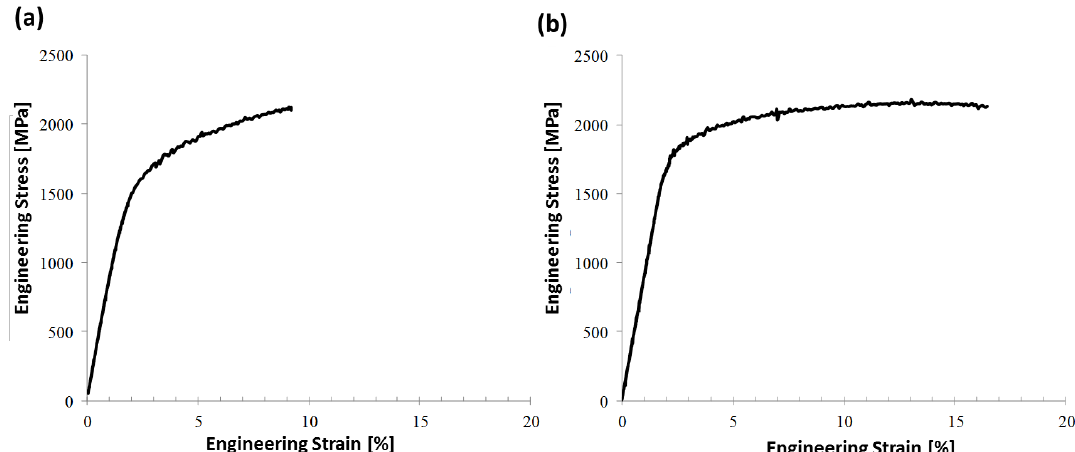
Figure 2. Engineering tensile strain-stress curves of two nanostructured bainite samples from different steels, both containing 1C–1.5Si wt %, but steel in ( a ) having 2Mn wt % and steel in ( b ) having 0.9Mn–2.6Ni wt % instead. Adapted from reference [37].